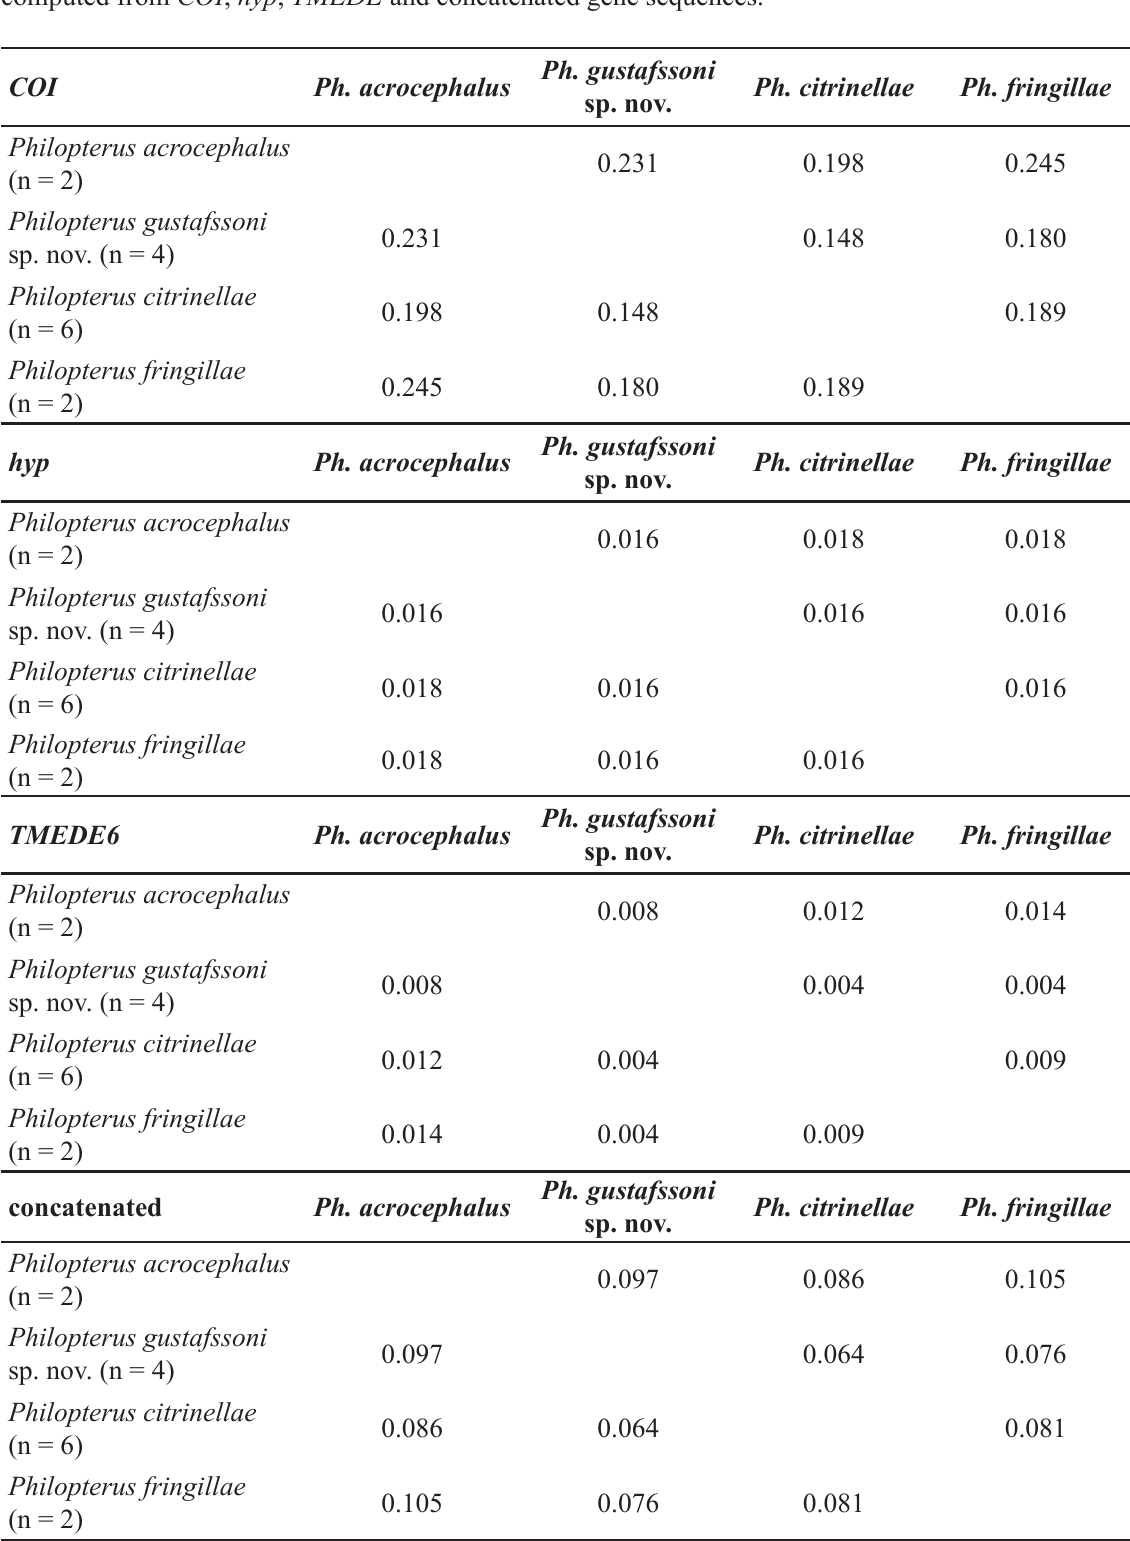
Table 5. Net interspecific p -distances of Philopterus acrocephalus Carriker, 1949, Philopterus gustafssoni sp. nov., Philopterus citrinellae (Schrank, 1776) and Philopterus fringillae (Scopoli, 1772) computed from COI , hyp , TMEDE and concatenated gene